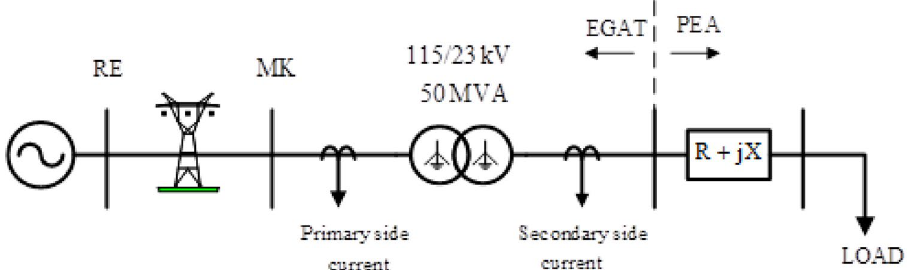
Figure 4. Single-line diagram of transmission line section used in case study.